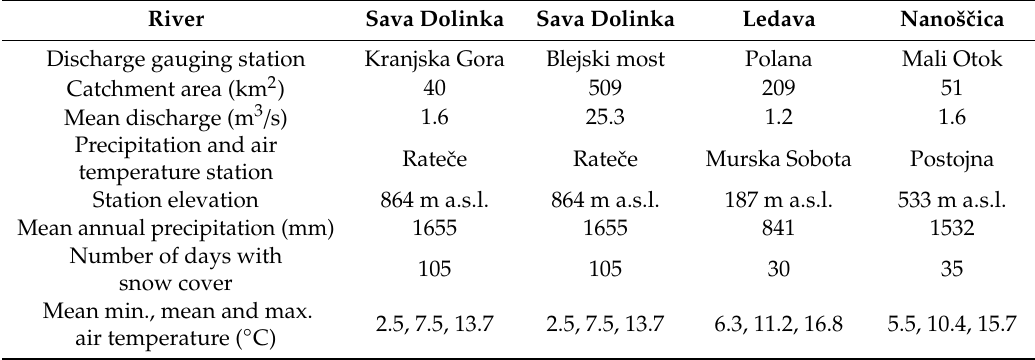
Table 1. Main characteristics of catchments used in this study for hydrological modelling. Mean discharge in the period of 2010–2018 as well as mean annual precipitation, number of snow days, and mean min., mean, and mean max. air temperature for the 2010–2019 period are